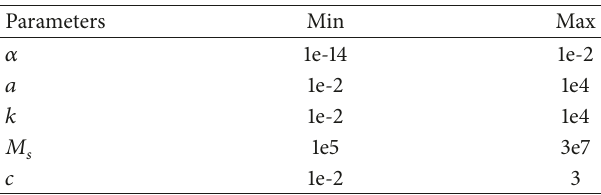
Table 1: Parameters search space.